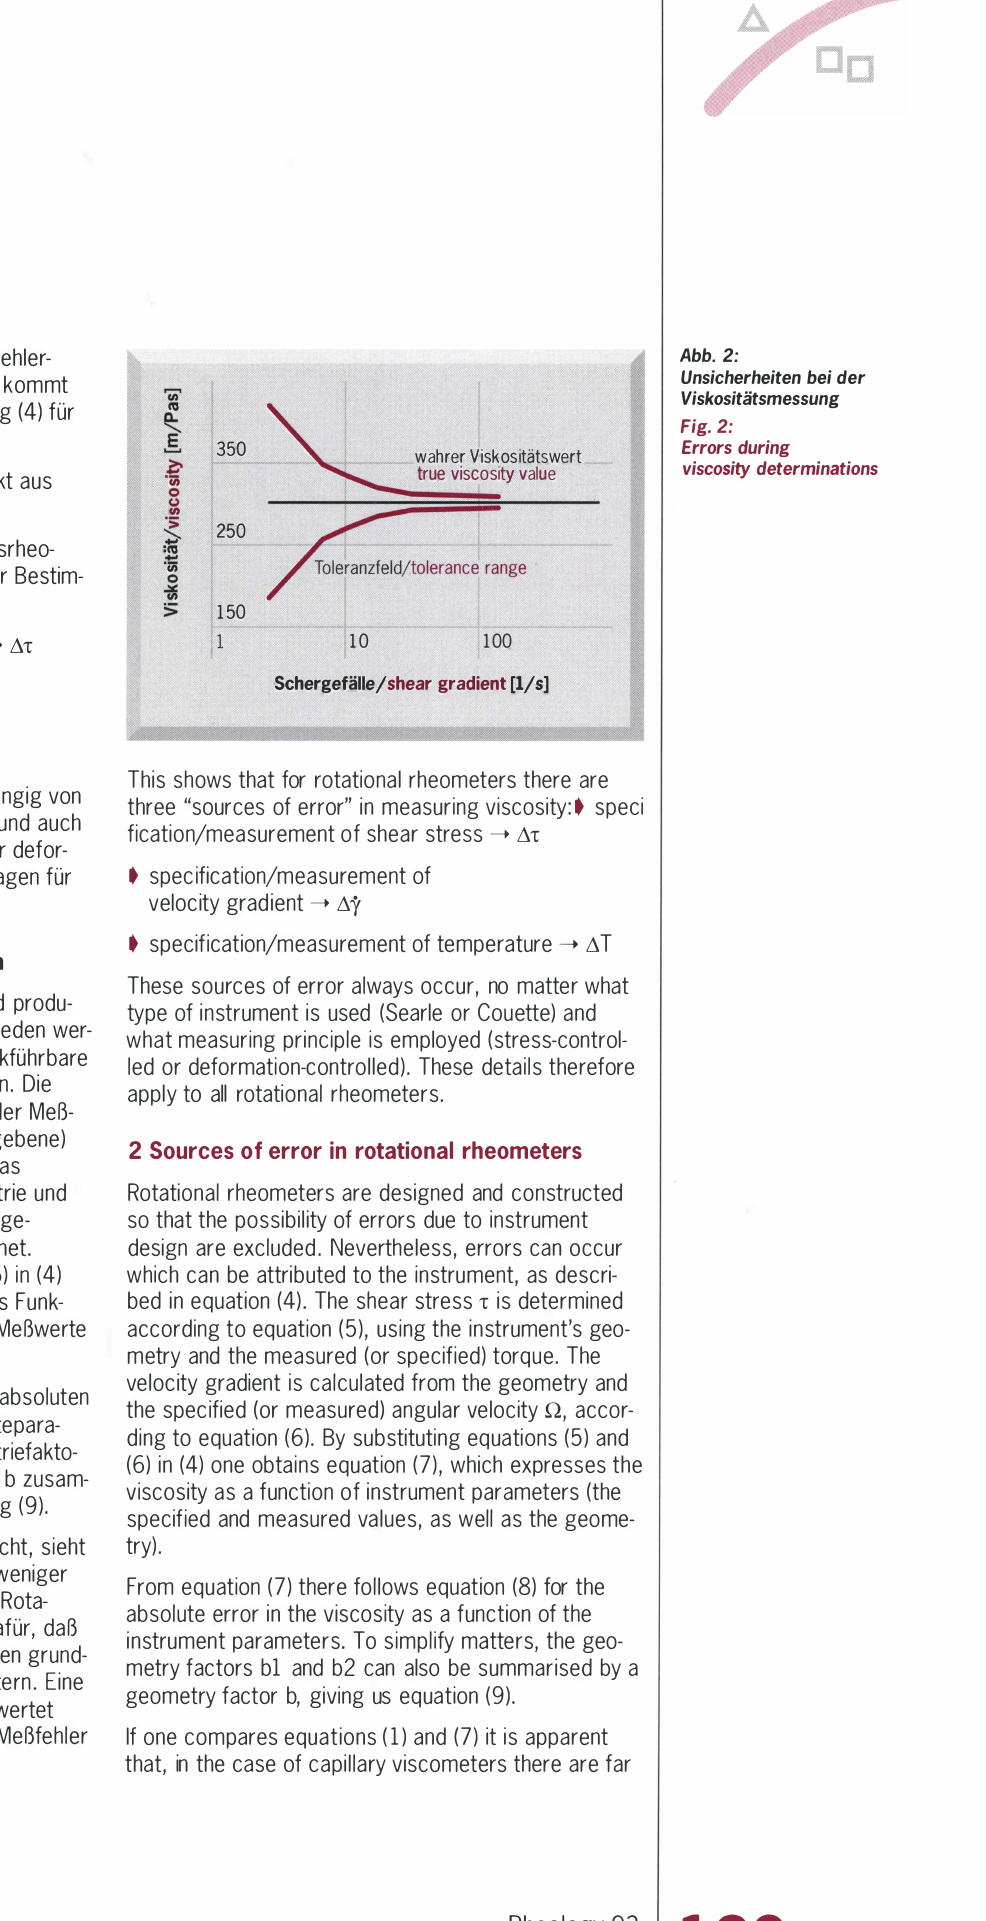
Fig. 2: Errors during viscosity